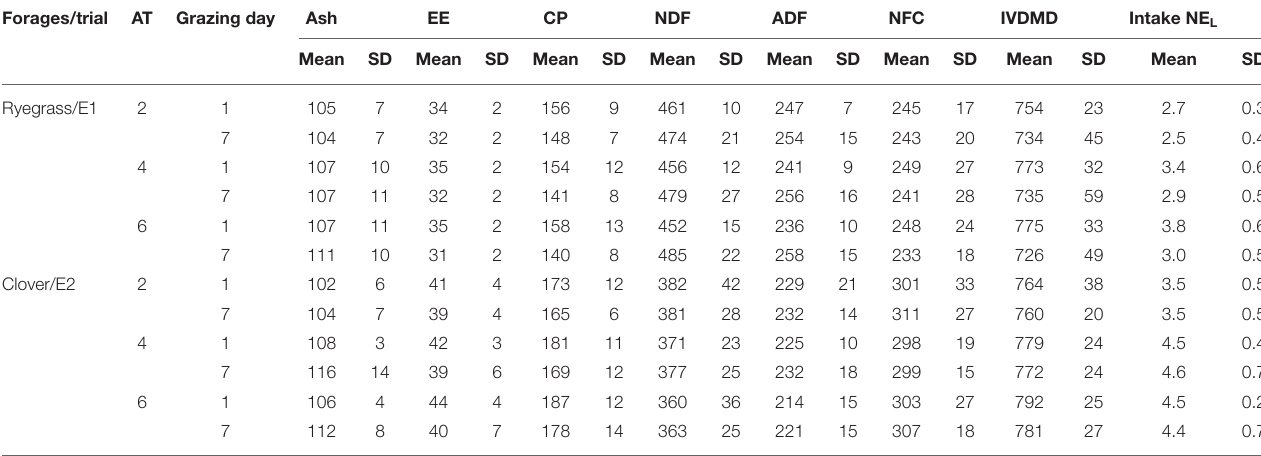
TABLE 1 | Diet composition and energy intake of dairy ewes part-time grazing (PTG) with different access time (AT, h/day) to pastures of Italian ryegrass or berseem clover as measured on the first (day 1) and last day (day 7) of the grazing period of 7 days. Forages/trial AT Grazing day